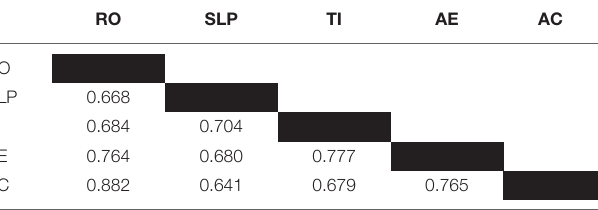
TABLE 4 | Discriminant validity (HTMT).